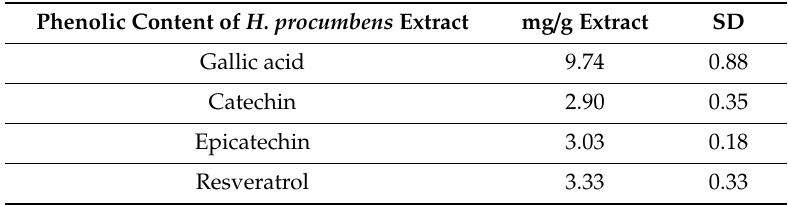
Gallic acid, catechin, epicatechin, and resveratrol (mg / g) extract determined via HPLC-fluorimetric analysis of the H. procumbens